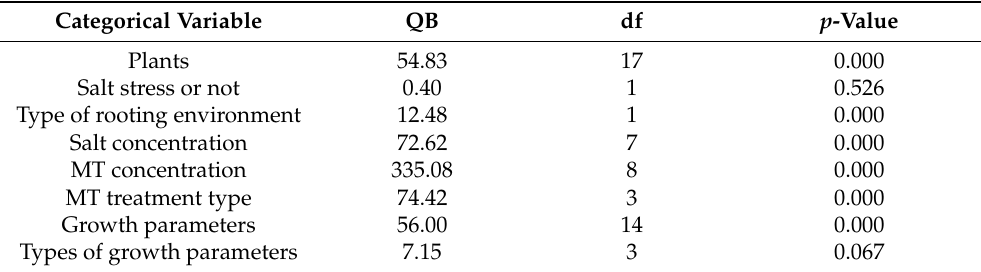
Table 2. Heterogeneity and p -value for the direct seeding effect size on growth across different categorical